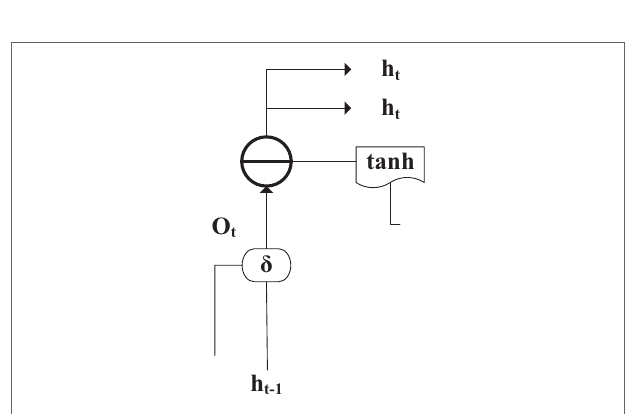
FIGURE 13 | The structure of the memory unit output